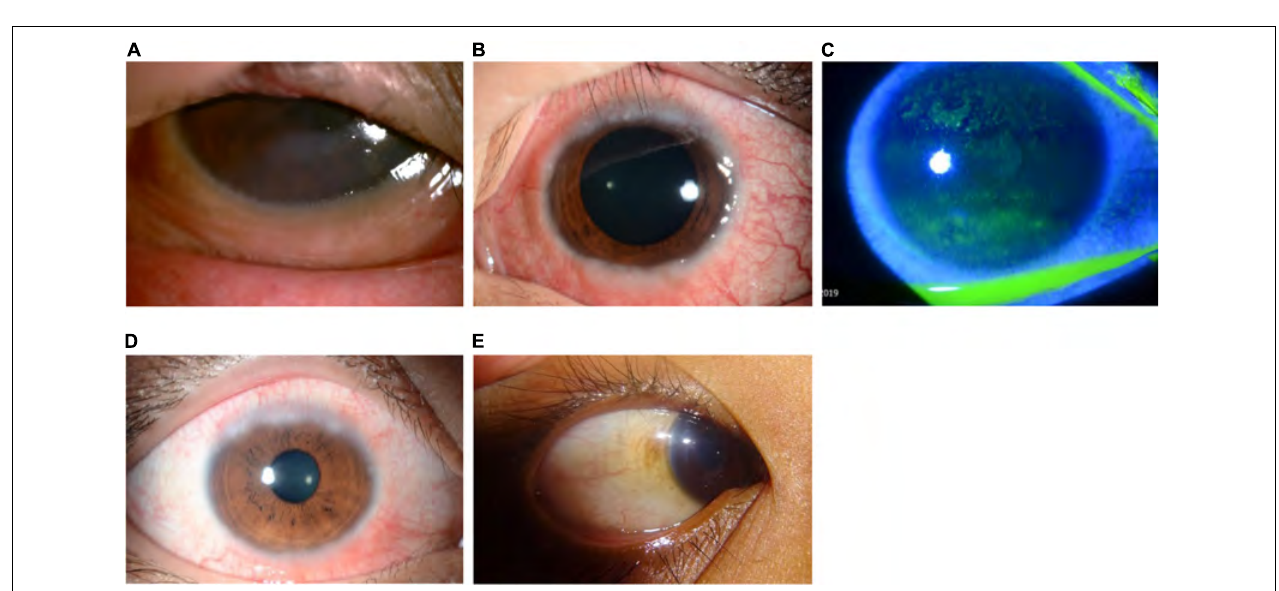
FIGURE 2 | Clinical subtypes of VKC: Tarsal form . The tarsal form is characterized by large, cobblestone-like papillae on the upper tarsal conjunctiva. (A) Image courtesy of Jodhbir S. Mehta; (B) image courtesy of Douglas K. Lam.